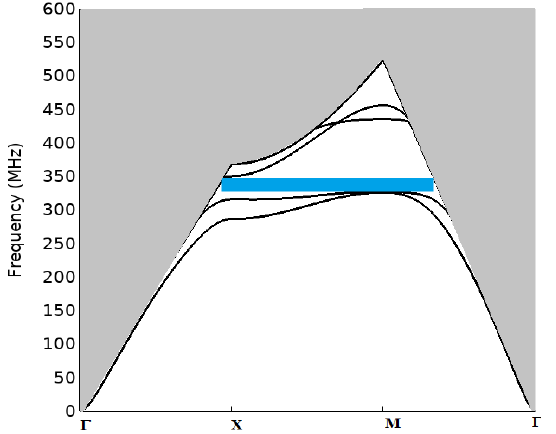
Figure 6. Acoustic band structure of PnC AlN pillars with r = 3 µm, and h = 2.4 µm. The blue area corresponds to the position of the acoustic band hatched area corresponds to the position of the acoustic band gap.